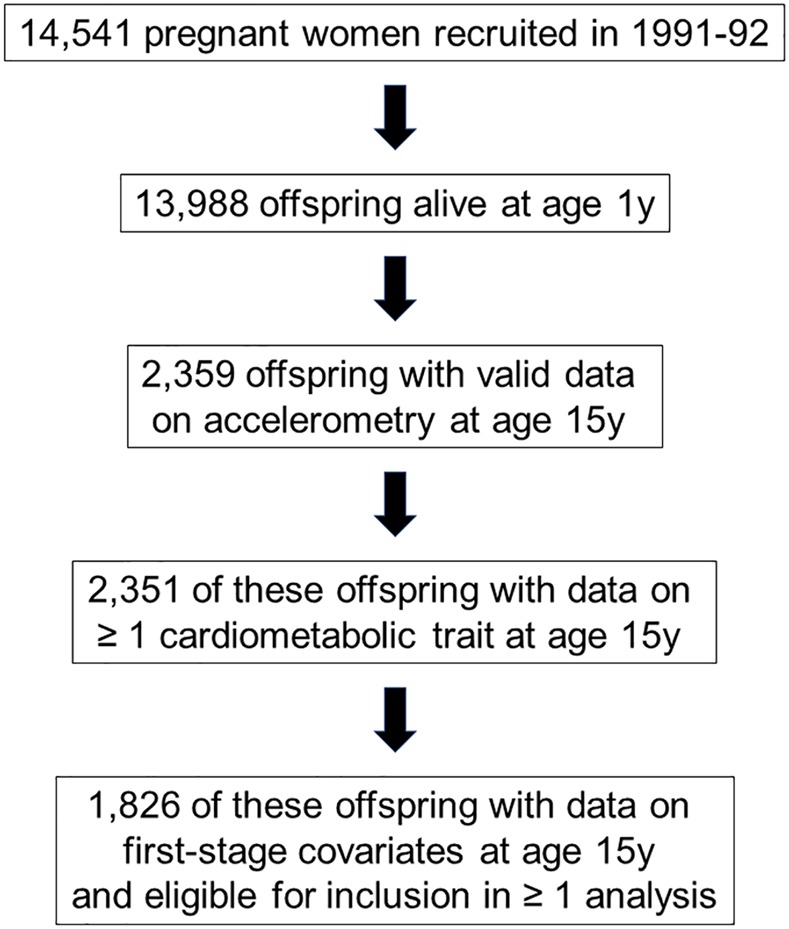
Selection of participants from the ALSPAC offspring cohort eligible for ≥ 1 analysis.ALSPAC, Avon Longitudinal Study of Parents and Children.